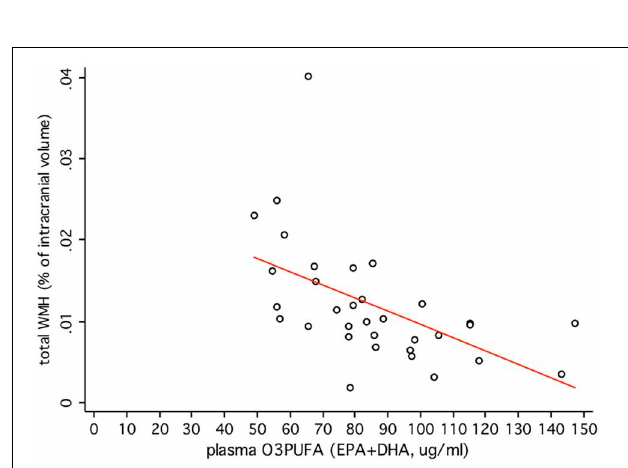
worse executive function (prolonged completion time for Trail B test). (C) Higher O3PUFA and better executive function (shorter completion time for Trail B test). (D) Association between O3PUFA and better executive function is lost once WMH is added to the regression model ( P = 0 . 332) representing mediation.